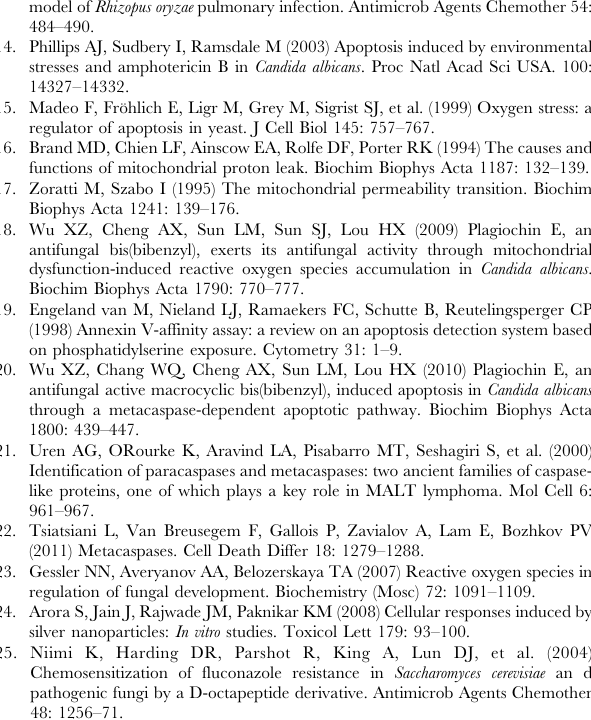
Figure S1 Changes in ROS levels and DY m in R. oryzae germlings triggered by treatment with PCZ or ICZ alone and in the presence or absence of NAC. (A) DHR-123 staining of germlings showing increased red fluorescence. (B) Rh- 123 staining of germlings showing increased green fluorescence, indicating loss of DY m . DIC, differential interference contrast. (C) Relative fluorescence of R. oryzae cells stained with DHR-123. (D) Relative fluorescence of R. oryzae cells stained with Rh-123. The experiments were performed in triplicate and repeated three times. Error bars indicate standard deviations. ***, p , 0.0001, NS, p . 0.05, compared to AA + BHAM untreated controls. (TIF) Figure S2 Representative fluorescent images of R. oryzae cells treated with PCZ or ICZ and untreated control cells. (A) Annexin V/PI double staining showing apoptotic cells (green fluorescence) and necrotic cells (red fluorescence). DIC, differential interference contrast. (B) Percent- ages of cells displaying annexin V/PI double staining. ***, p , 0.0001, compared to AA + BHAM untreated controls.